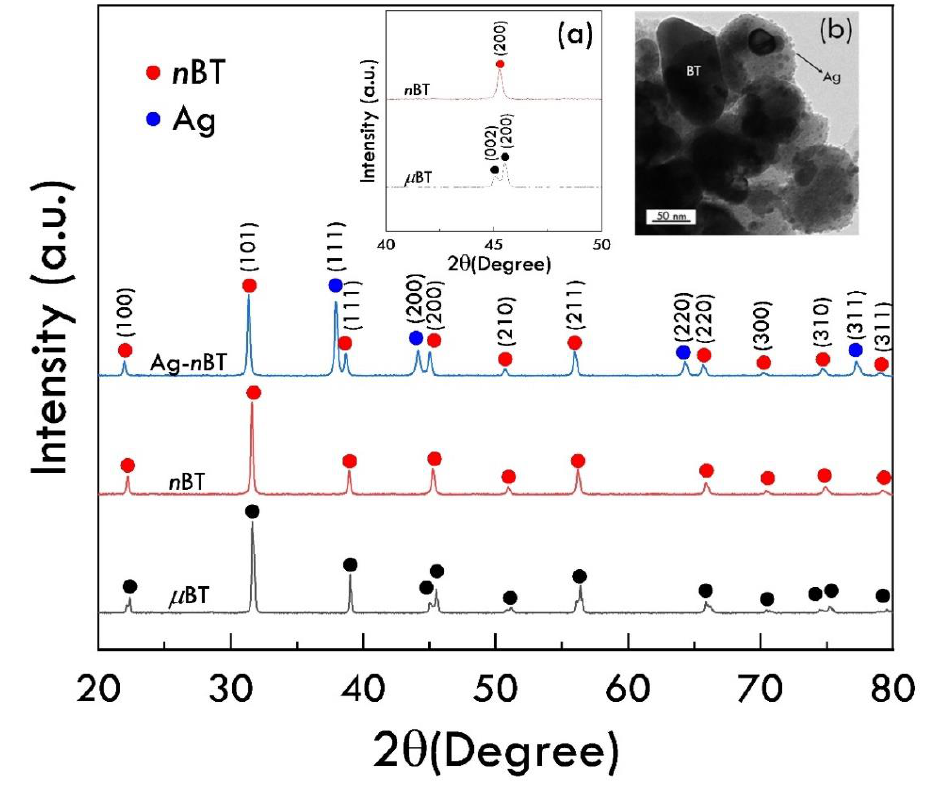
Figure 2. XRD patterns of µ BT, n BT, and Ag- n BT hybrid particles; insets ( a ) and ( b ) show expanded view near 2θ ≈ 45°, revealing the tetragonal phase of BT, and TEM image of hybrid particles, respectively.